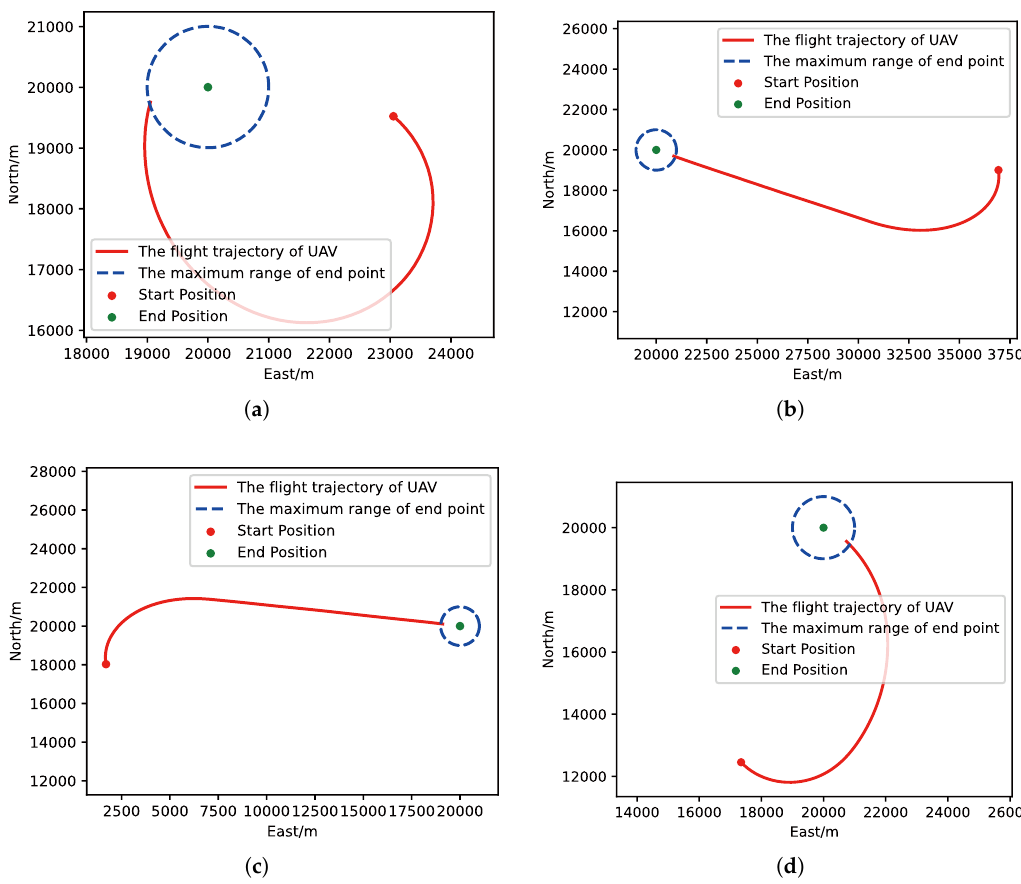
Figure 17. The flight trajectory from MC experiments for the trained result of UER-DDPG: ( a ) The flight trajectory of 1st experiment. ( b ) The flight trajectory of 2nd experiment. ( c ) The flight trajectory of 3rd experiment. ( d ) The flight trajectory of 4th experiment.